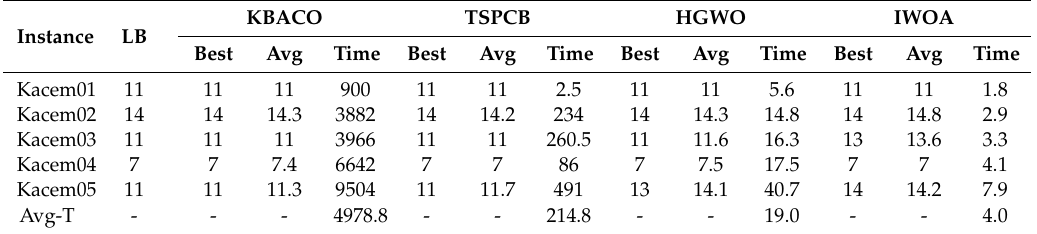
Table 2. Comparison between the proposed improved WOA (IWOA) and existing algorithms on the KAdata. See Section 5.3 for column descriptions.